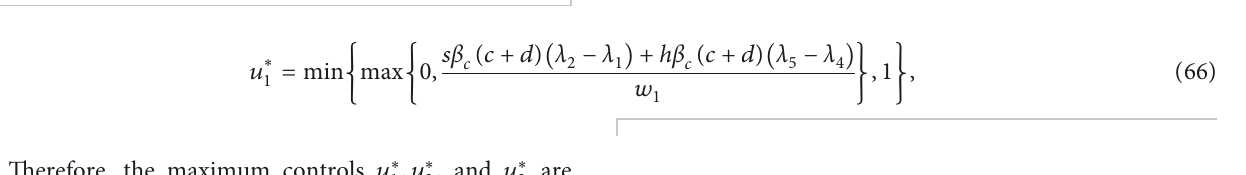
Figure 6: The simulations of cholera infected population with and without